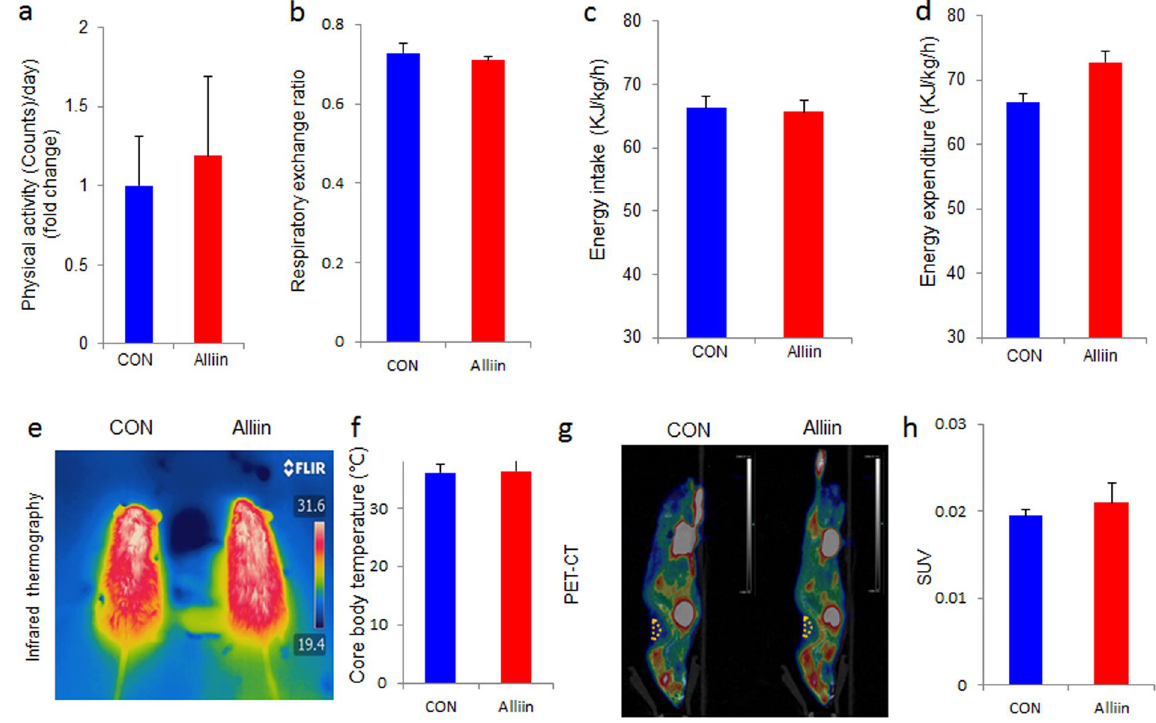
Figure 4. Alliin does not change the whole-body energy metabolism in DIO mice. Alliin did not affect ( a ) the physical activity, ( b ) the respiratory exchange ratio, ( c ) energy intake or ( d ) energy expenditure. No significant difference of ( e and f ) the core body temperature between alliin treated and the control DIO mice under cold condition. Both ( g ) the sagittal view of PET-CT images and ( h ) quantified SUV showed that alliin treatment did not affect brown adipose tissue activity in DIO mice. Data are means ± SEM (n = 6). Yellow triangle: anatomic site of interscapular BAT. SUV, standard uptake